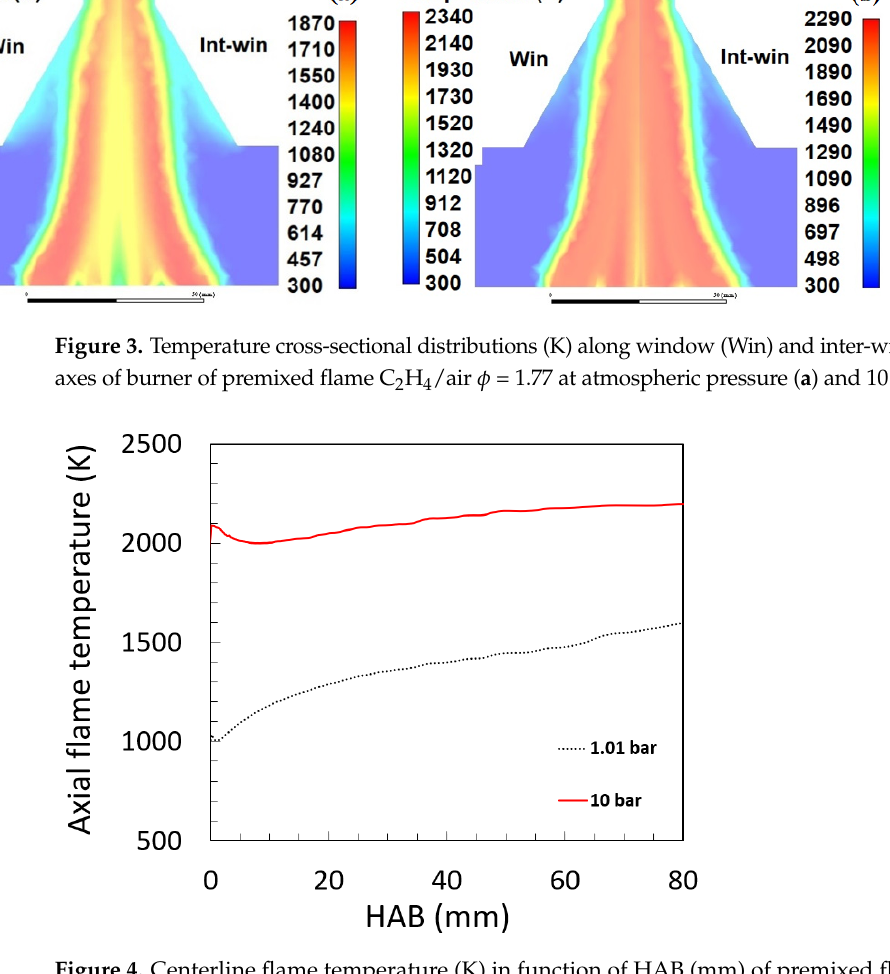
Figure 5. Cross-sectional distribution of radial flow velocity (m/s) along window and inter-window axes of burner of premixed flame C 2 H 4 /air ϕ = 1.77 at atmospheric pressure ( a ) and 10 bar ( b ).